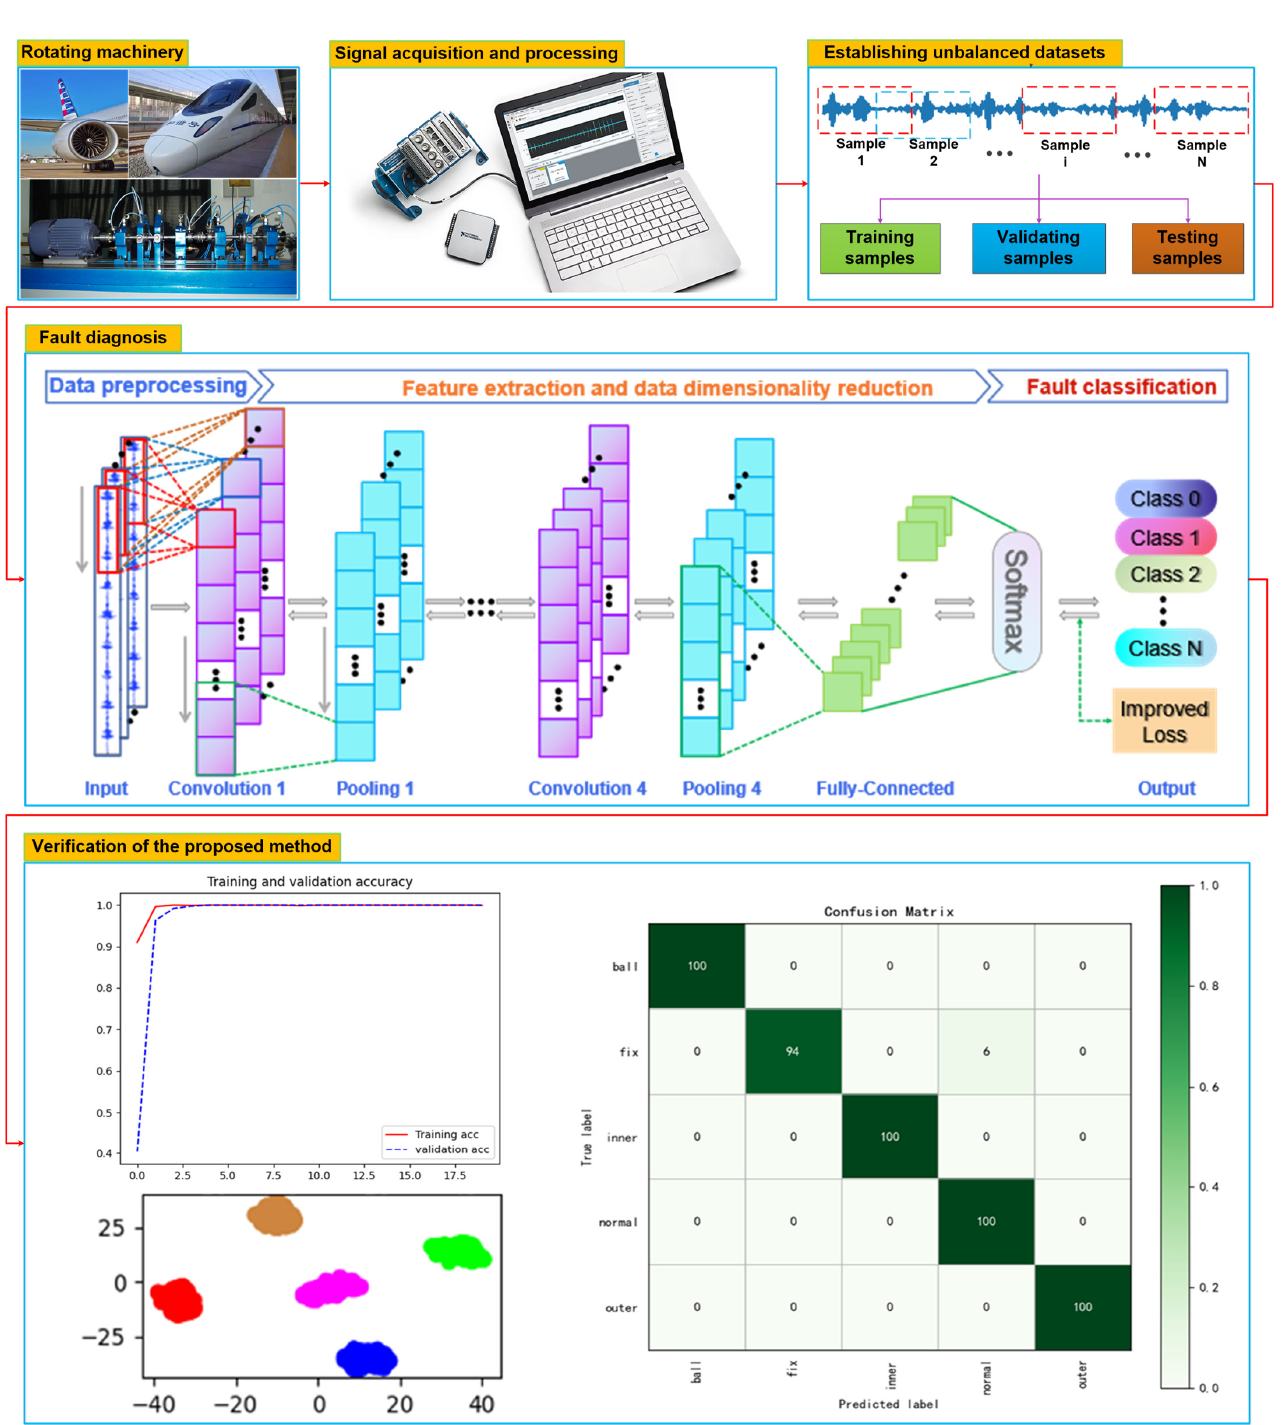
Figure 3. Flow chart of the fault diagnosis method based on 1DCNN and L2-SVM.